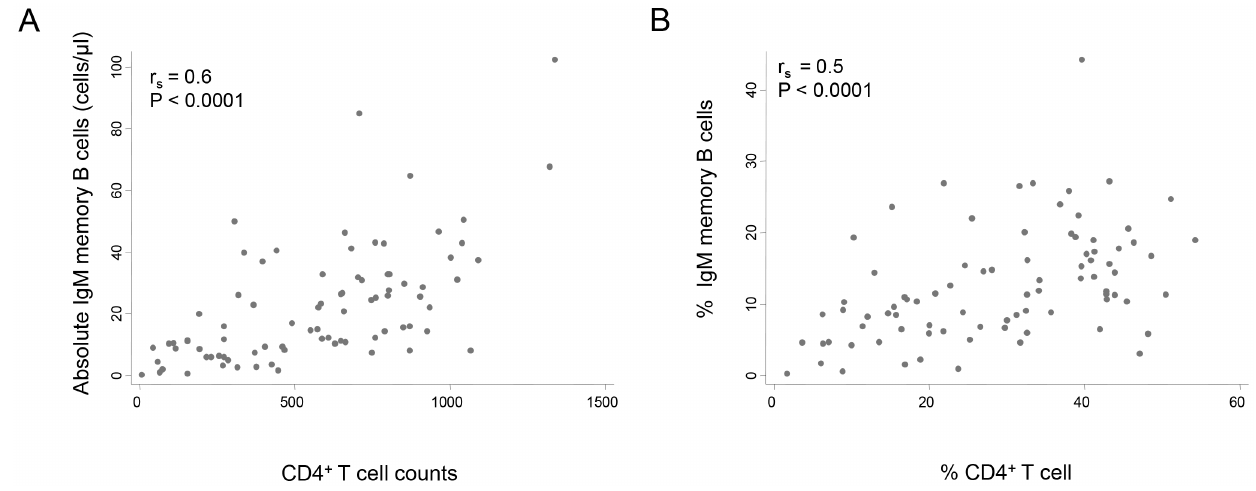
Figure 3. Correlation between circulating IgM memory B-cells and CD4 + T-cells. ( A ) Scatter plots showing absolute IgM memory B-cell numbers & CD4 + T-cell counts and ( B ) % IgM memory B-cells & CD4 + T-cells measured using flow cytometry. The association between the two parameters (IgM memory B-cells and CD4 counts) was determined by Spearman’s correlation using Stata (Version 10). Each point represents the result from one subject. r s is the Spearman rank correlation coefficient.